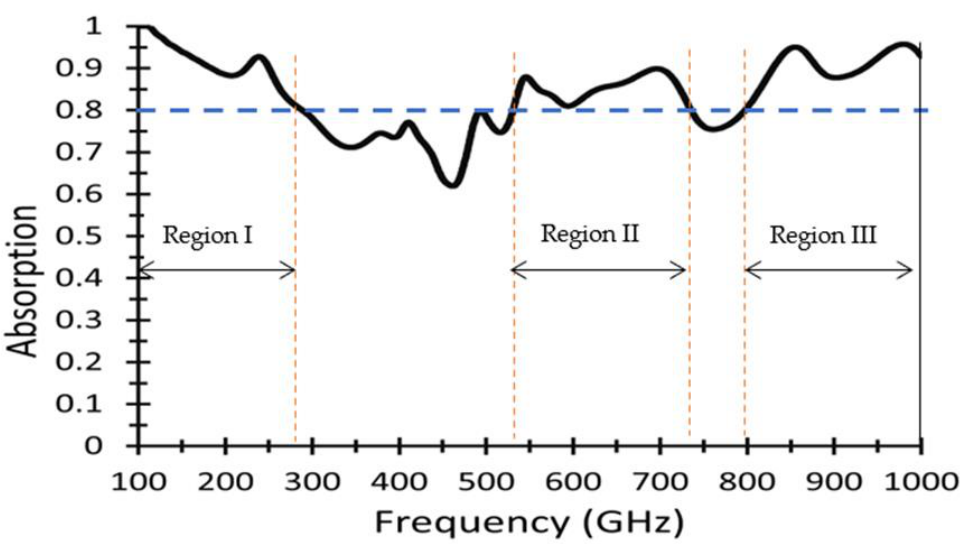
Figure 12 . The optimum absorption is more than 65% in the range 100 – 1000 GHz, and with 65.5% of the band over 80%